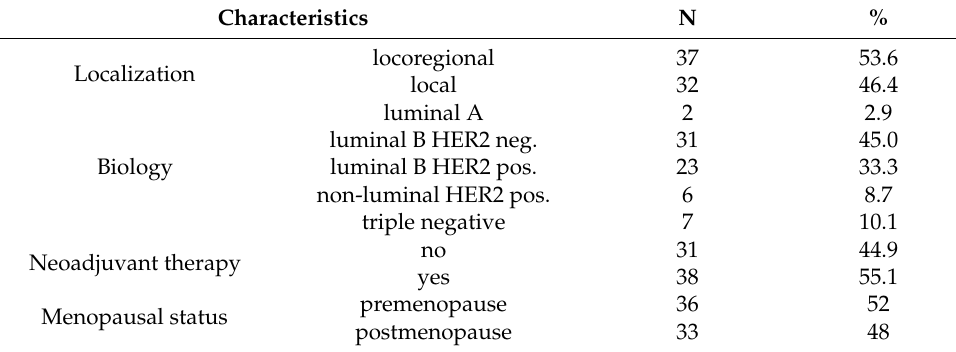
Table 1. Patient characteristics (N =